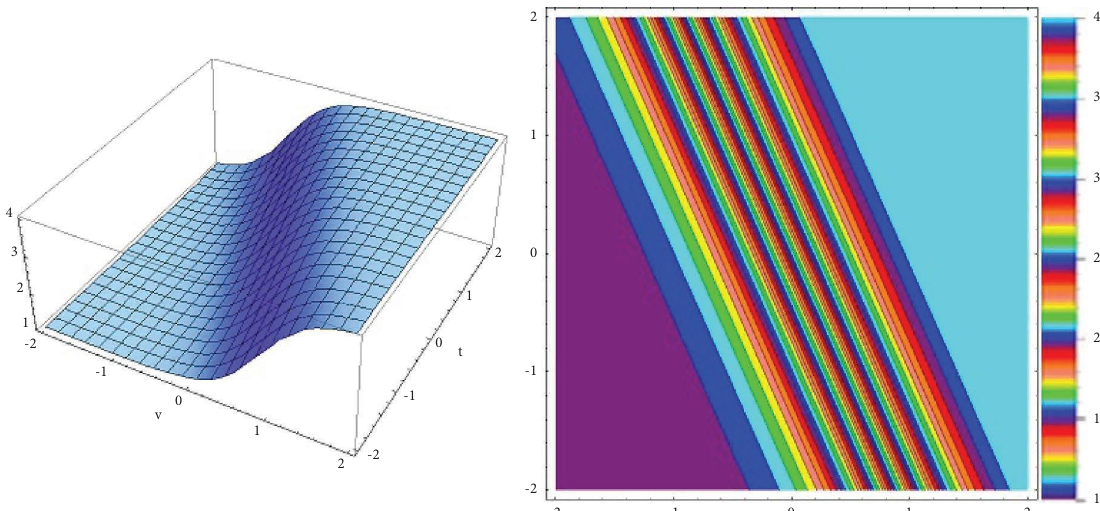
Figure 12: Flat kink shape soliton drawing from (36) for ω � 2 . 25.